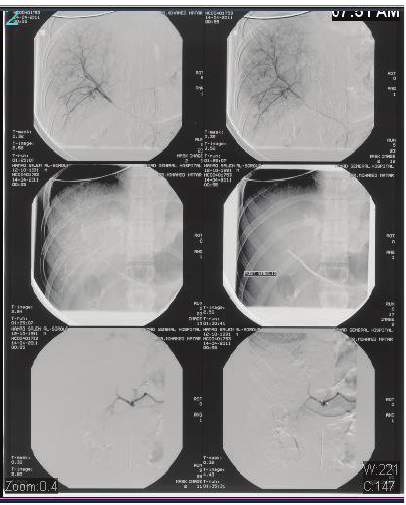
Figure 2: Selective angiogram of hepatic vessels with evidence of active blush, foam embolization, and immediate good control.